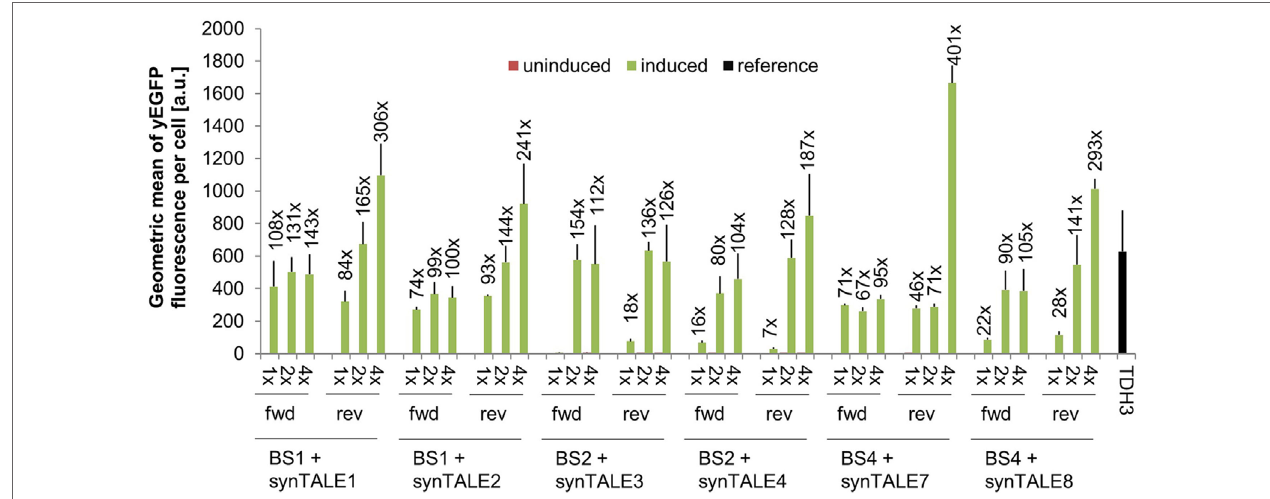
FigUre 2 | Synthetic transcription activator-like effectors (synTALEs) confer inducible reporter gene expression from synthetic promoters (synPs). yEGFP fluorescence of yeast cells with corresponding synTALE/synP pairs was analyzed by flow cytometry. SynTALE expression was induced with IPTG in galactose containing medium. Background activity of synPs was measured in glucose containing medium without IPTG. Values from uninduced samples are always very low. Induction of at least 2-fold is indicated. 1 × , 2 × , 4 × : binding site (BS) copy number. Fwd, rev, forward/reverse orientation; a.u., arbitrary units; TDH3, TDH3-yEGFP measured in medium without